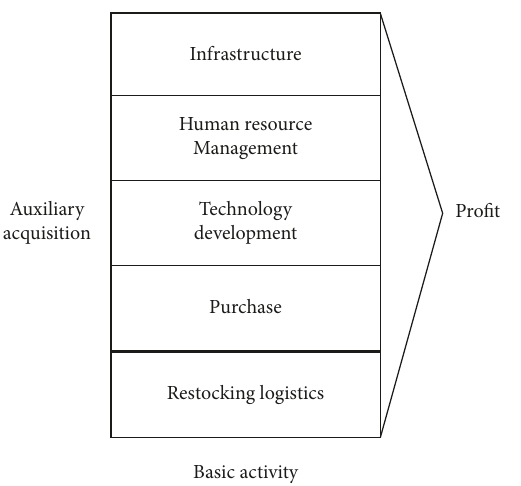
Figure 5: Value chain